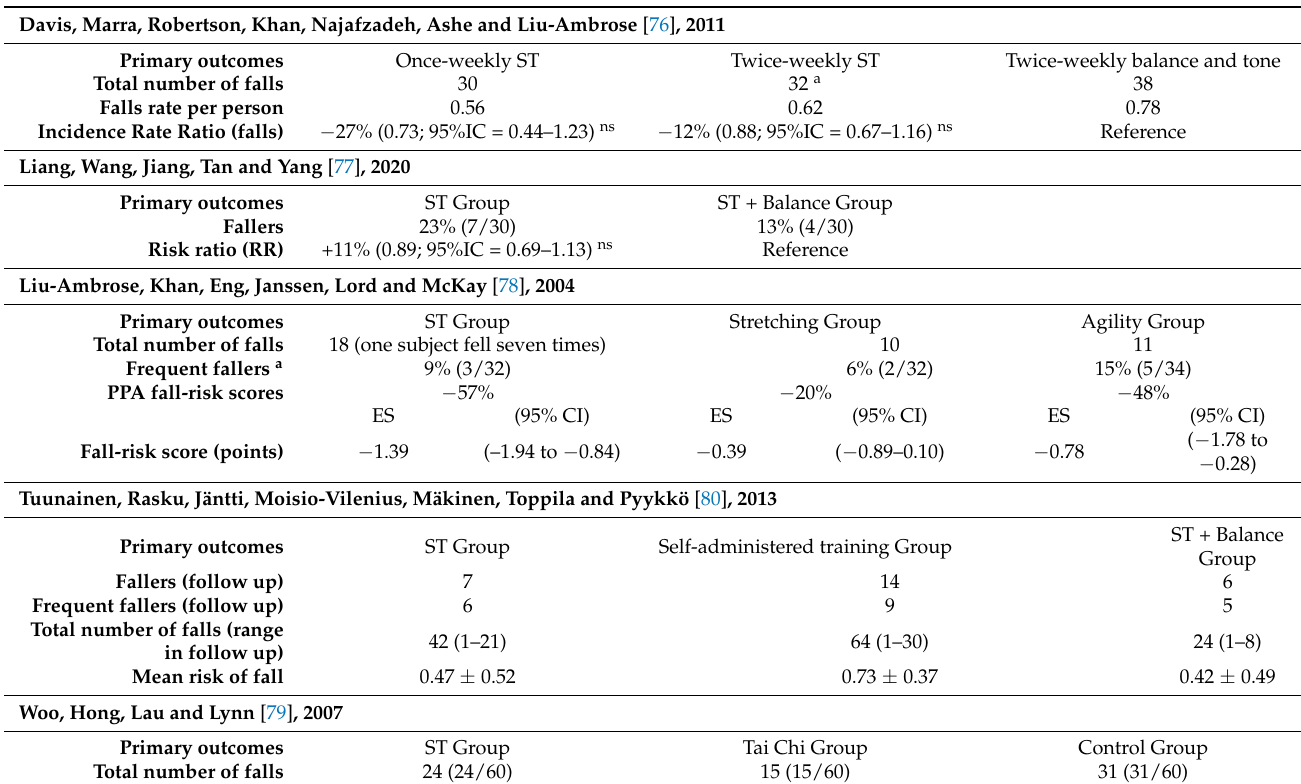
Table 2. Results of individual studies (synthesized